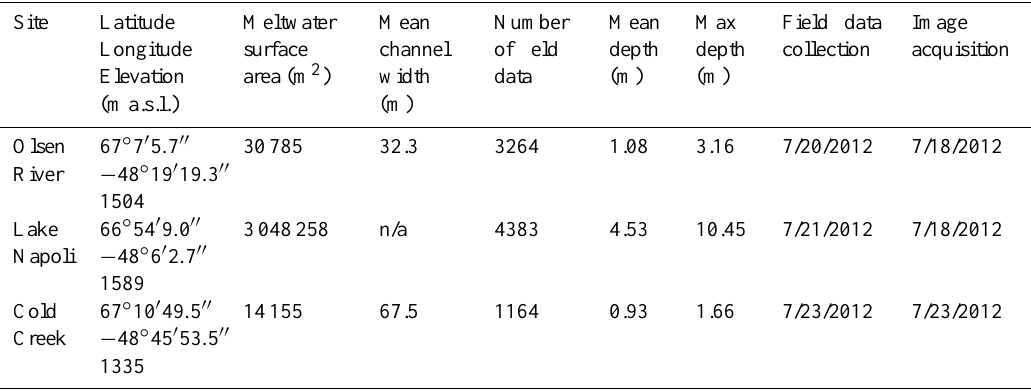
Table 1. Study sites on the surface of the Greenland ice sheet (GrIS) from which field-based measurements of depth and reflectance and WorldView2 satellite images were